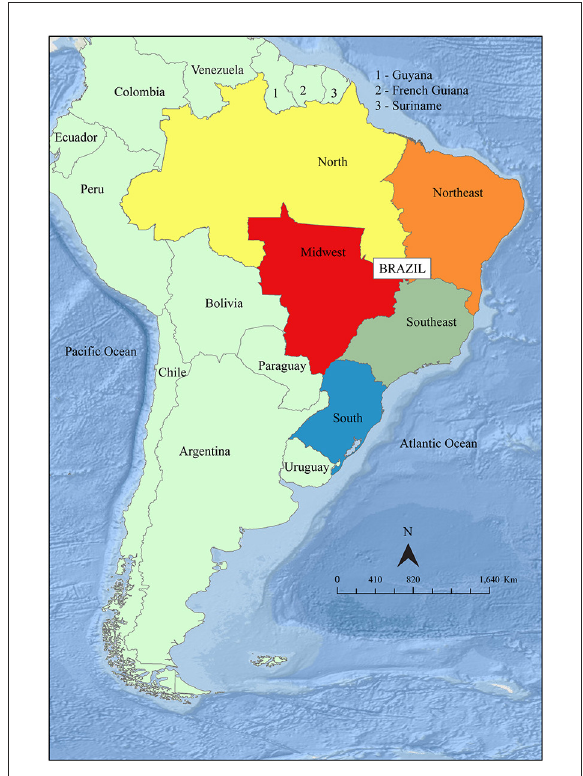
FIGURE1 Map of Brazil showing the five Brazilian regions. The map was constructed by the authors.